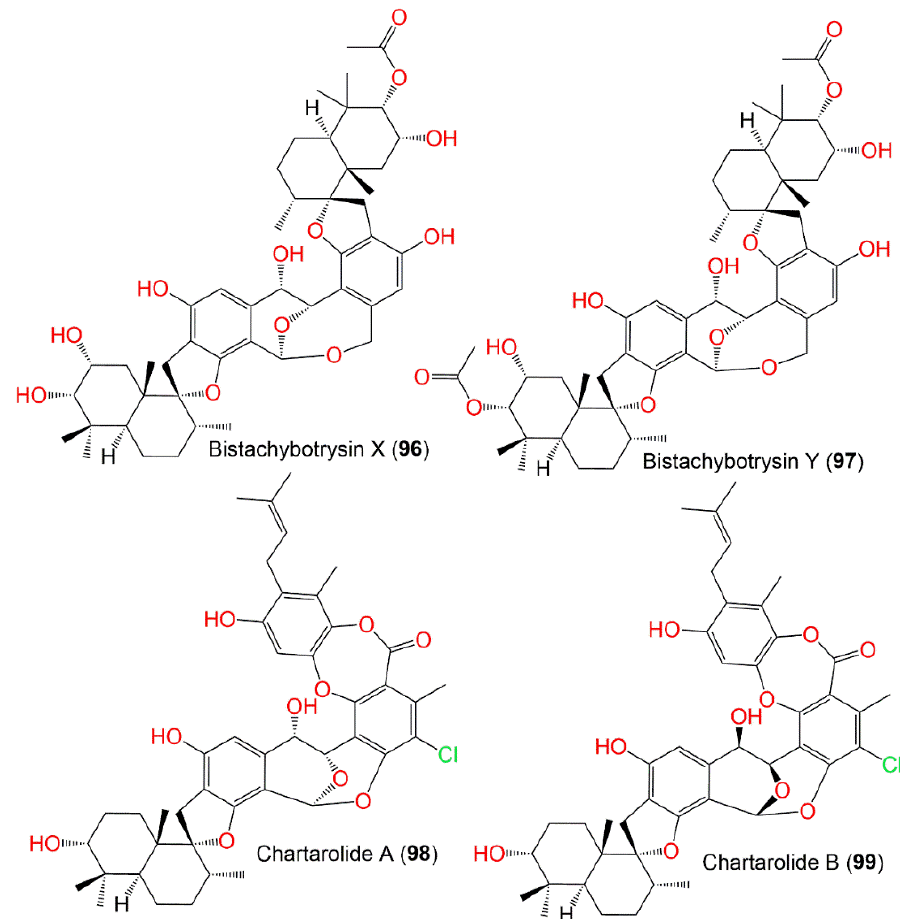
Figure 12. Structures of dimeric phenylspirodrimane derivatives ( 96 – 99 ) reported from S . chartarum .